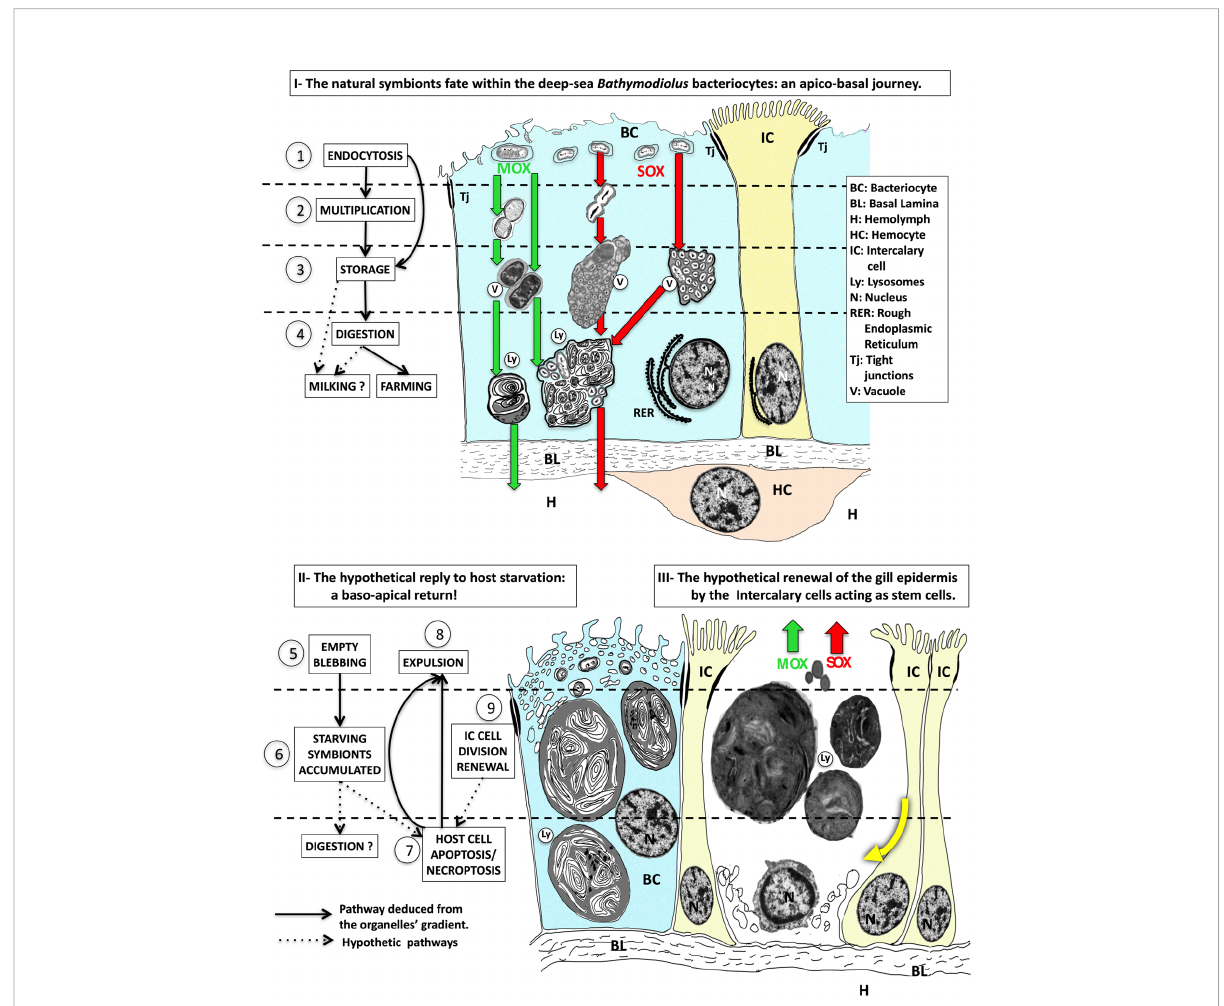
FIGURE 8 The interpreted model of the forth and back traf fi cking of the symbionts and their host cells during symbiont starvation. - Part I - Hypothetical apico-basal pathway when symbionts are present in the bacteriocytes, with the successive steps 1) endocytosis of the symbionts, 2) symbionts multiplication, 3) symbiont storage in vacuoles, 4) symbionts digestion in lysosomes, which leads to either digestion (i.e. farming) and/or leakage of small molecules that crosses the basal lamina and reaches the hemolymph (i.e. milking). MOX (green arrows) and SOX (red arrows) symbionts are stored in separate vesicles in B azoricus from Menez Gwen, (left green and red arrows), but together in mixed vacuoles in B puteoserpentis from Lucky Strike (right green and red arrows). The nucleus of the bacteriocyte is basal surrounded by rough endoplasmic reticulum. Intercalary cells are colored in yellow, and hemocytes in pale brown. Part II - The hypothetical response to host starvation leading to 5) empty blebbing, 6) accumulation of starving and destroyed symbionts, 7) Host cell apoptosis/necroptosis and expulsion (8). Part III Finally, intercalary cell division (9) and cellular movements (thick yellow curved arrow) below the missing bacteriocyte suggest intercalary cells might be the stem cells that enable gill epithelial renewal. The real sources of these schemes correspond to frequently observed and photographed cell features: step 1 see Figures 4A, B; step 2 see Figure 4C, D; step 3 see Figures 4E, F; step 4 see Figures 4G, H; step 5 see Figures 5A, B, step 6 see Figures 5C, D; step 7 & 8 see Figures Figure 5E – G; step 9, see Figures 6A,